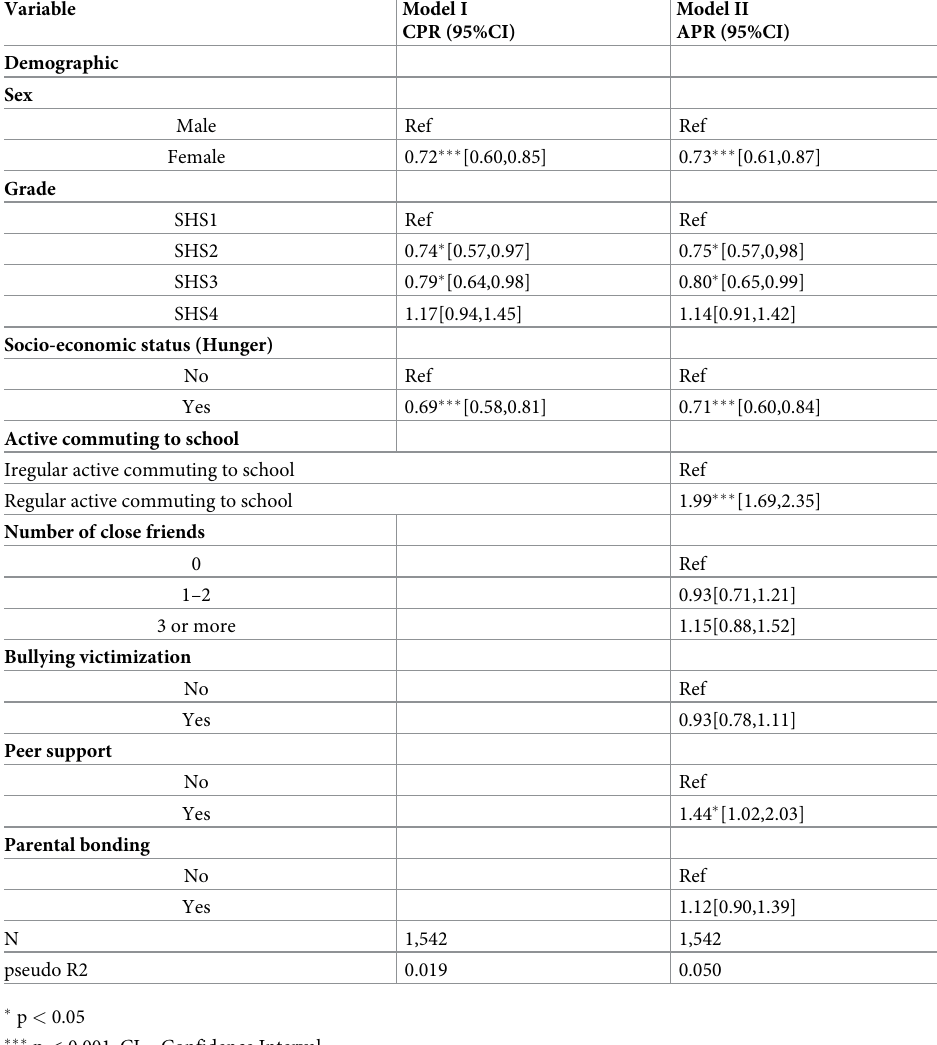
Table 2. Crude Prevalence Ratios (CPR) and Adjusted Prevalence Ratios (APR) of physical activity among SHS students in